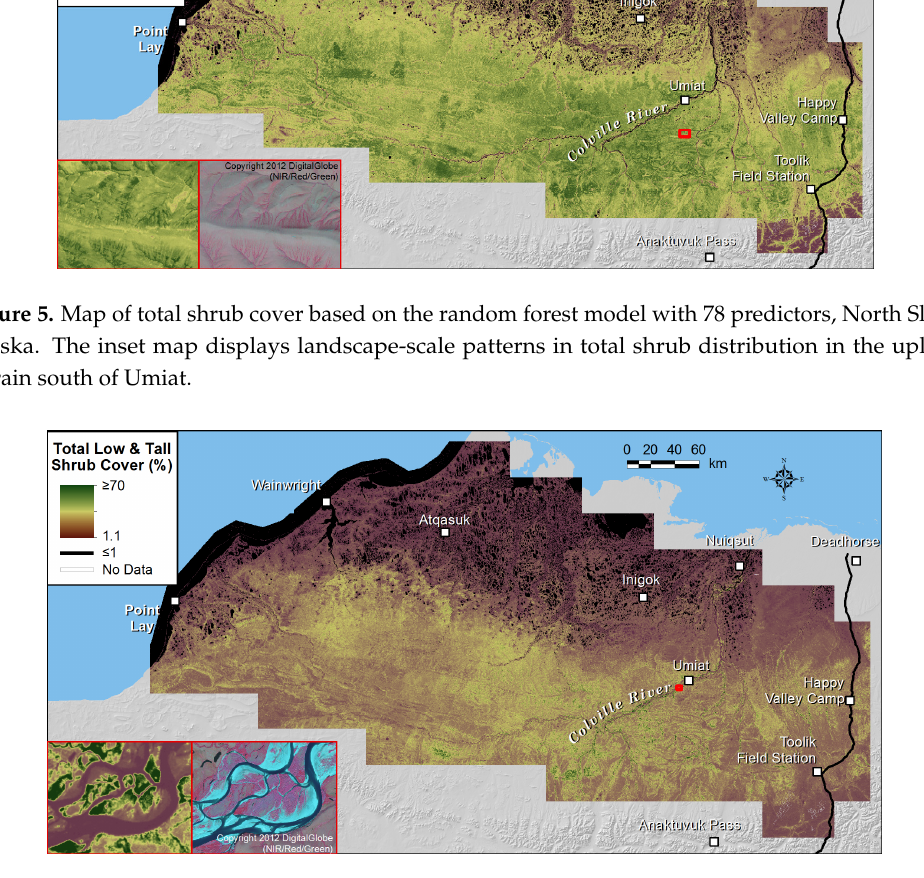
Figure 6. Map of total low and tall deciduous shrub cover based on the random forest model with 78 predictors, North Slope, Alaska. The inset map displays examples of highly productive shrublands on the active floodplain of the Colville River.